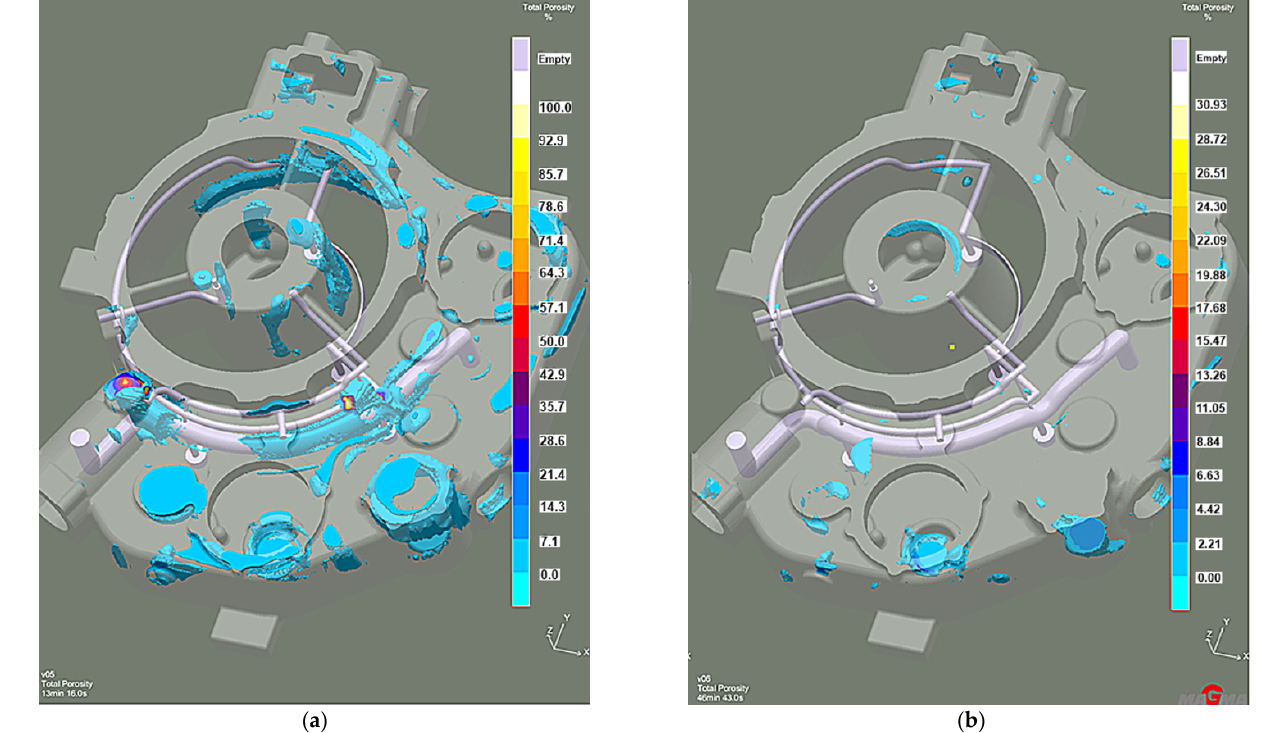
Figure 14. Stage 4 Total Porosity criterion: ( a ) the system without feeding elements; ( b ) the system with top feeding risers.